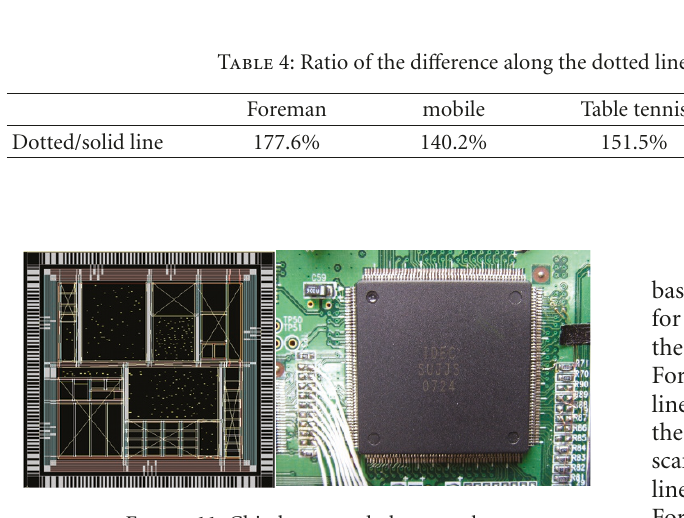
Figure 11: Chip layout and